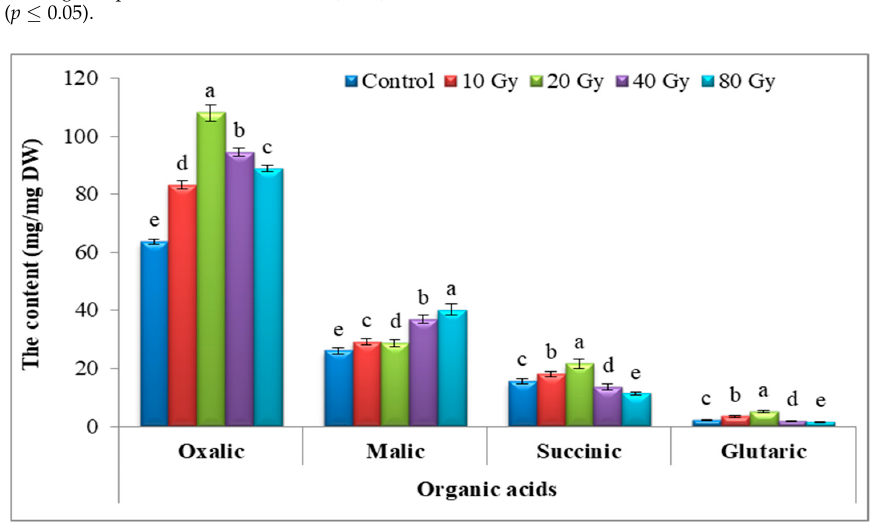
Figure 9. Organic acids content (mg/mg DW) of red radish plants affected by different doses of gamma rays. Findings are means ± standard deviations (n = 3). Different letters point to significant differences at p ≤ 0.05; bars indicate standard deviations.